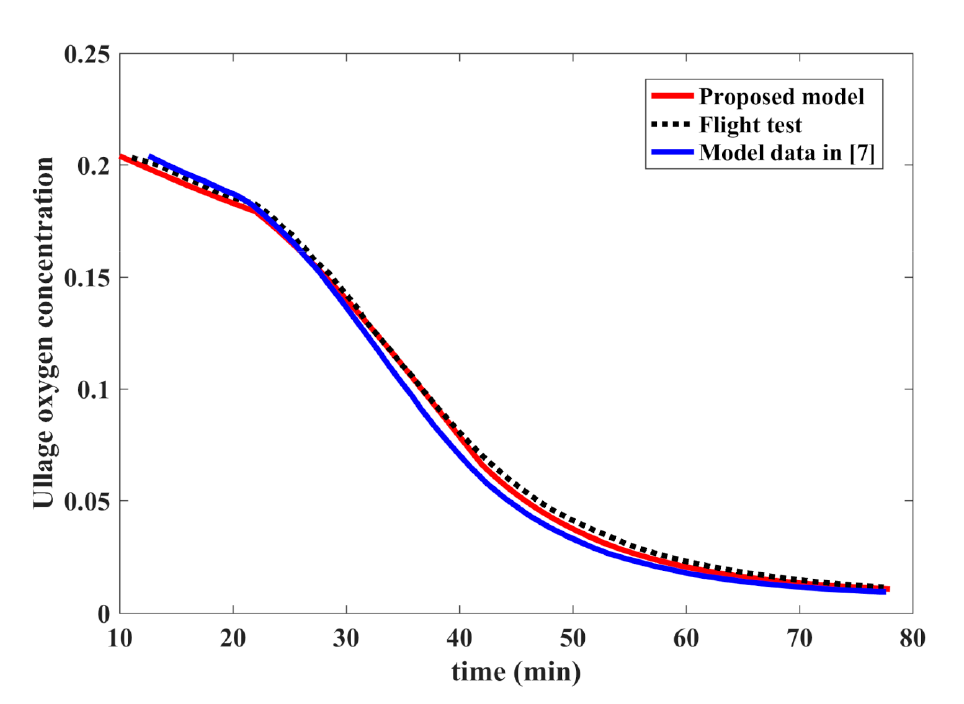
Figure 6. Flight test and calculated results of z Uov in climb and cruise